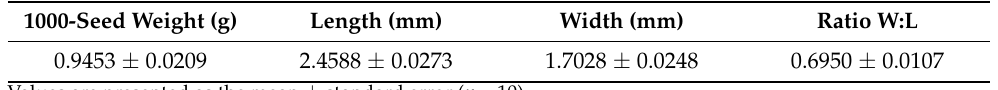
Figure 1. Embryo growth, radicle emergence, and seedling emergence of Vaccinium oldhamii Miq. ( A ) V. oldhamii seed ( B ) 7, ( C ) 14, ( D ) 21, ( E ) 28, ( F ) 35, ( G ) 42, and ( H ) 49 d into the germination process. SC = seed coat, EM = embryo, ES = endosperm, RDC = radicle. Scale bar = 1 mm. Table 1. Seed characteristics of Vaccinium oldhamii Miq.